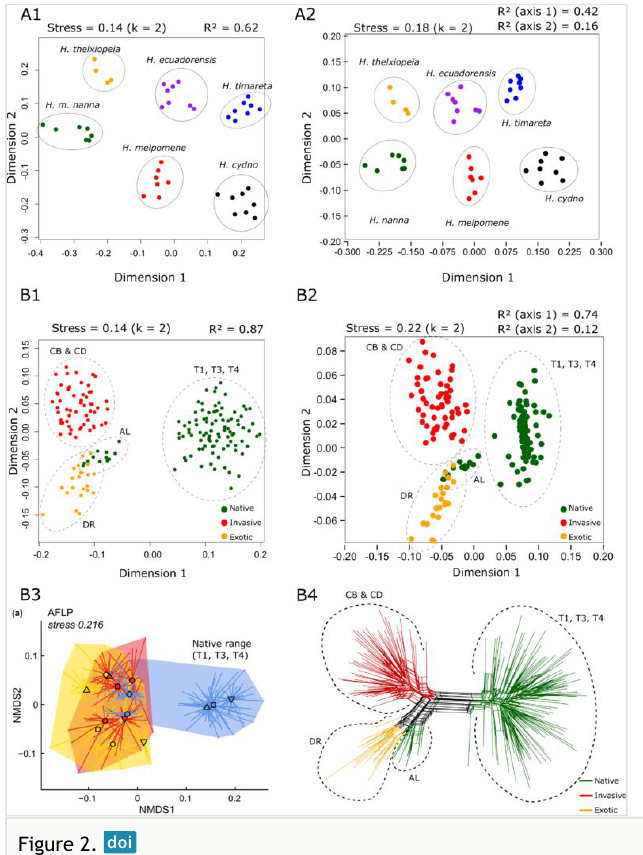
Figure 2. Comparisons of non-metric multidimensional scaling (nMDS) plots in BinMat ( A1 and B1 ) and PAST ( A2 and B2 ). Both nMDS plots are plotted for k = 2 dimensions. Data were taken from Arias et al. 2014 (A1 and A2) and Tewes et al. 2018 ( B1 , B2 and B4 ). Stress and R values are shown above each plot. Diagram B3 shows the original nMDS plot presented by Tewes et al. 2018, which depicts the same clustering pattern of the native range samples (T1, T3 and T4). Diagram B4 shows the SplitsTree representation of the same data (NeighborNet, Jaccard